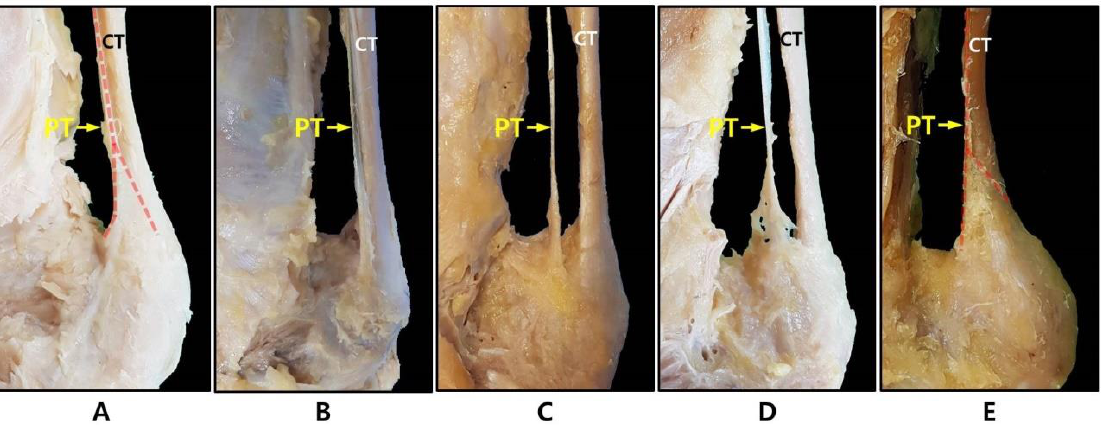
Figure 3. Photo of the classification of the PT according to insertion type. ( A ) Type 1; ( B ) Type 2; ( C ) Type 3; ( D ) Type 4; ( E ) Type 5. CT: calcaneal tendon; PT: plantaris tendon (red dashed line indicates plantaris tendon).